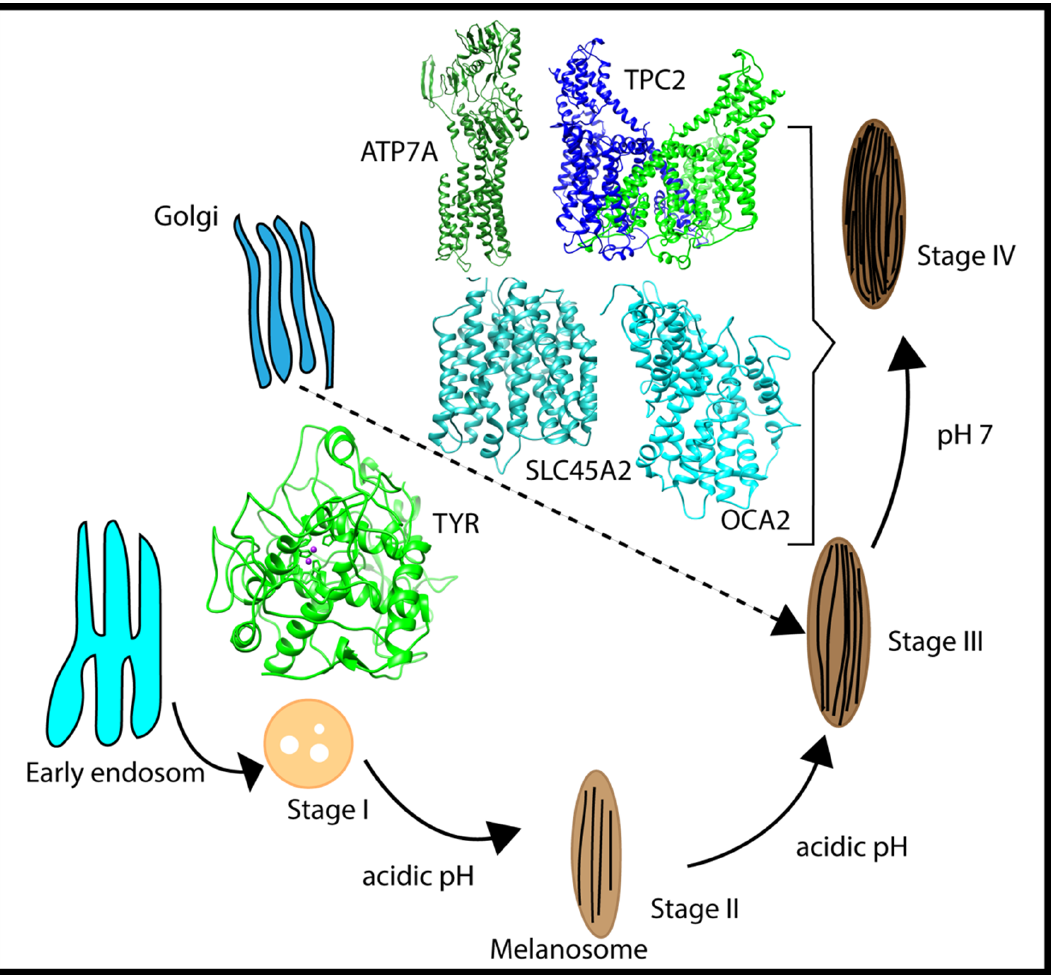
Figure 2. Schematic representation of the multistage processes of melanosome formation and proteins participating in pH regulation and melanin synthesis. The characteristic pH for each melanosome stage is also indicated in the figure.